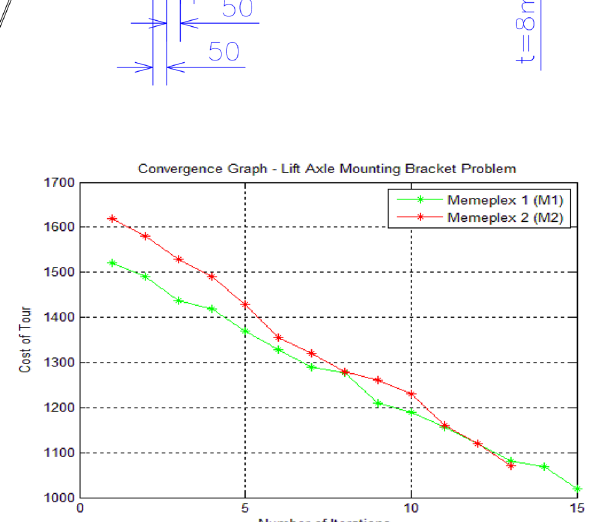
Fig. 3 MATLAB graph of the results for lift axle mounting bracket